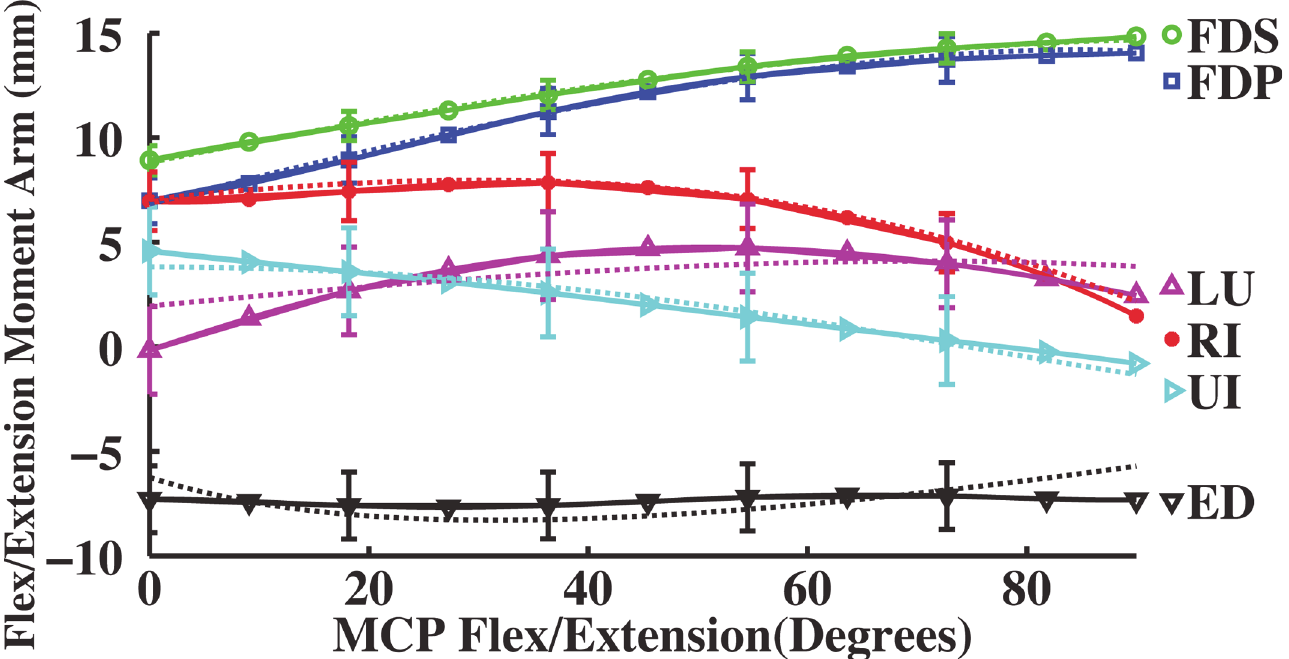
Fig 1. Measured and derived flex/extension moment arms (mm) as a function of flexion (+)/ extension (-) at the MCP joint of the index finger. Dotted moment arm values are derived from experimental muscle attachments [5], and solid moment arm values are direct measurements (n = 7 specimens with mean and standard deviation (error bar); [20]). Positive values indicate flexion moment arms, negative values indicate extension moment arms, and 0° is full extension.